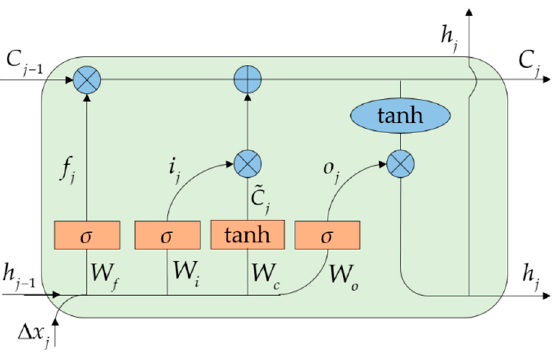
Figure 4. The architecture of the long short-term memory (LSTM) unit. The function of retaining and updating the cell state is the unique ability of the LSTM unit. (cid:101) C j is the temporary cell state, which is used to update the old cell state C j − 1 into new state C j . The state update process is determined by the cooperation of the forget gate f j and input gate i j . The weight matrices W